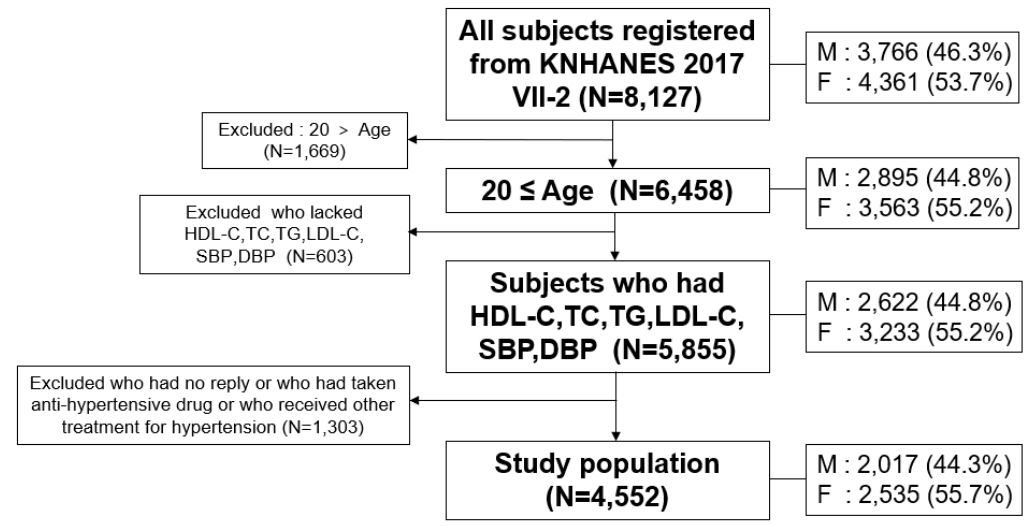
Figure 1. Inclusion criteria and subject number in analysis from KNHANES, Korean national health and nutrition examination survey; HDL-C, high-density lipoprotein cholesterol; TC, total cholesterol; TG, triglyceride; LDL-C, low-density lipoprotein-cholesterol; SBP, systolic blood pressure; DBP, diastolic blood pressure; M: men; F: female. blood pressure; M: men; F: